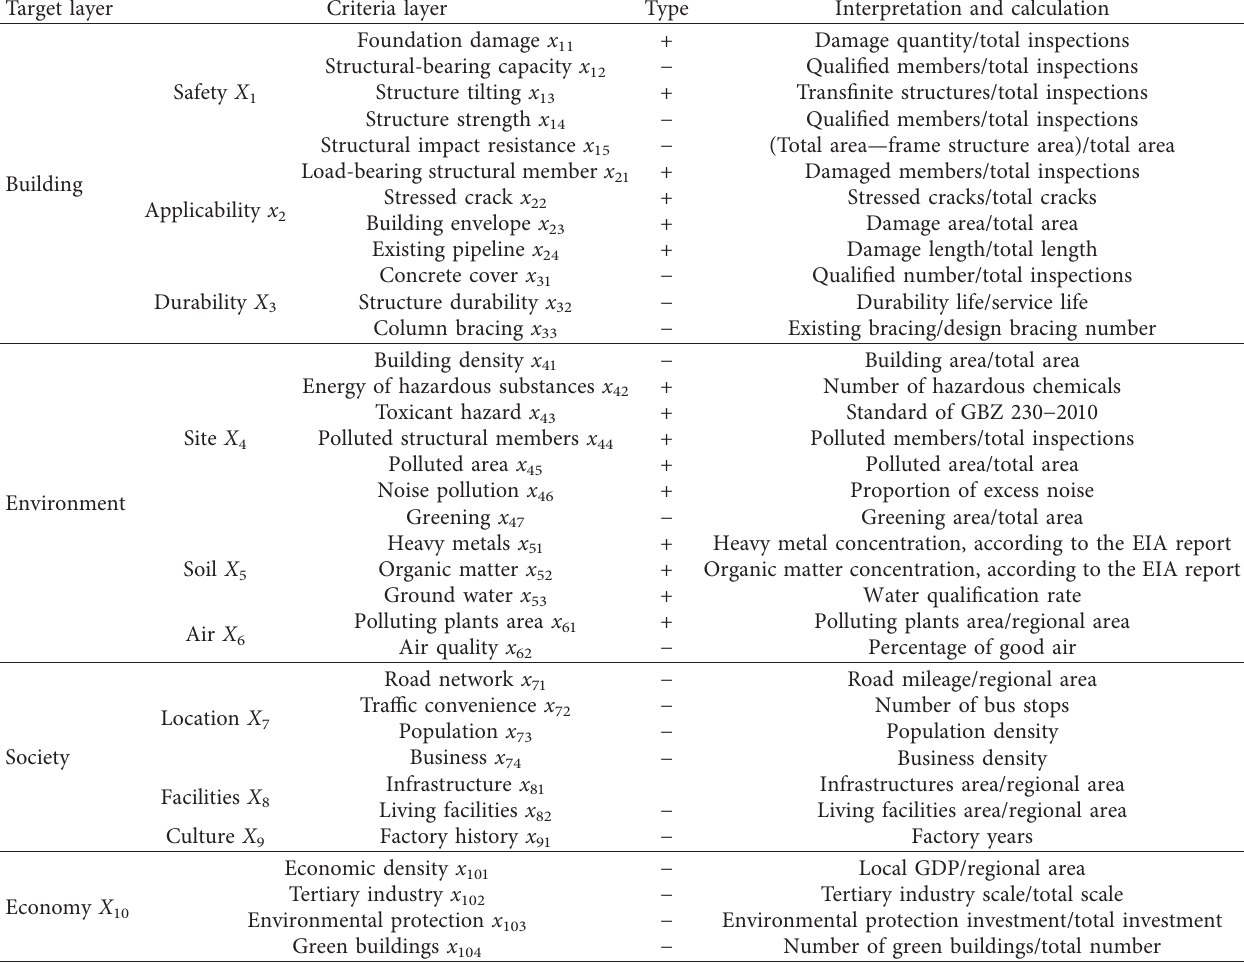
Table 1: The vulnerability assessment indicator system for reusing old industrial